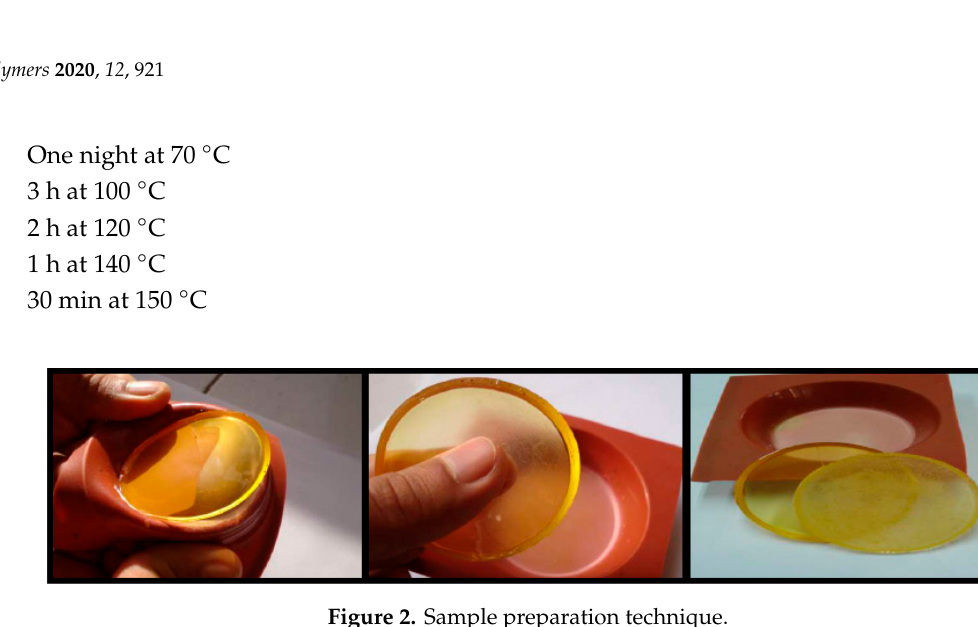
Figure 2. Sample preparation technique.